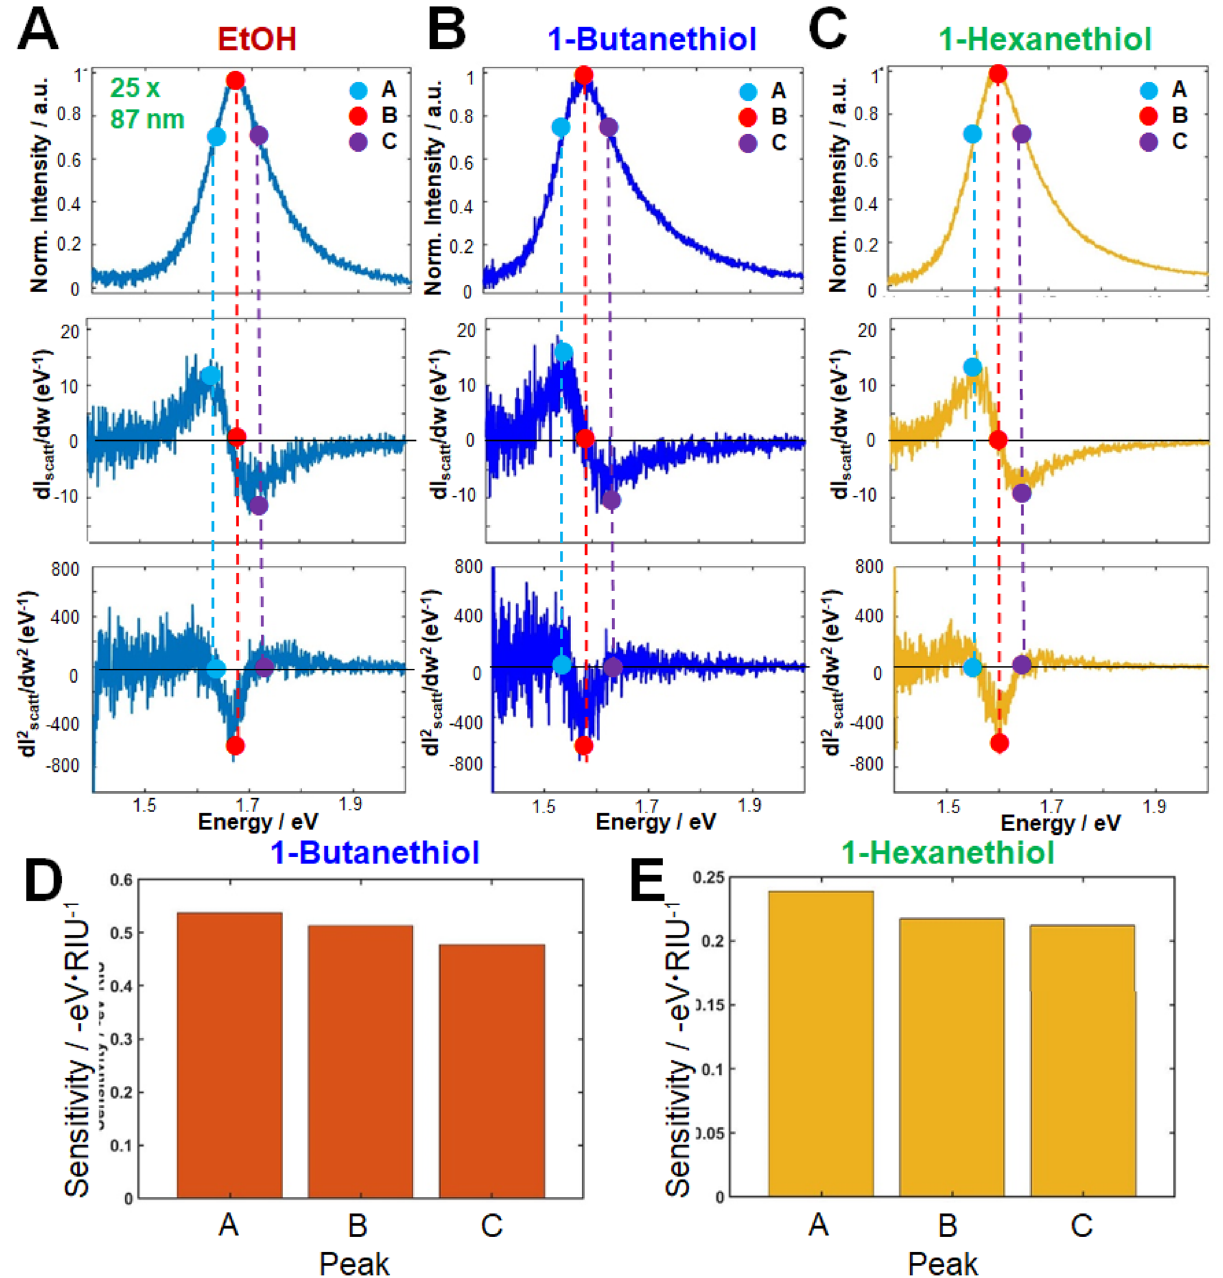
Figure 7. Inflection-point method for single-particle LSPR scattering sensing with AuNRs (25 nm × 87 nm, AR = 3.5) in the presence of 1-alkanethiols (1-butanethiol and 1-hexanethiol) in ethanol: ( A–C ) LSPR scattering efficiencies (first row), and their first-order (second row), and second-order (third row) derivatives; ( D, E ) Detection sensitivities of peak shifts in A, B and